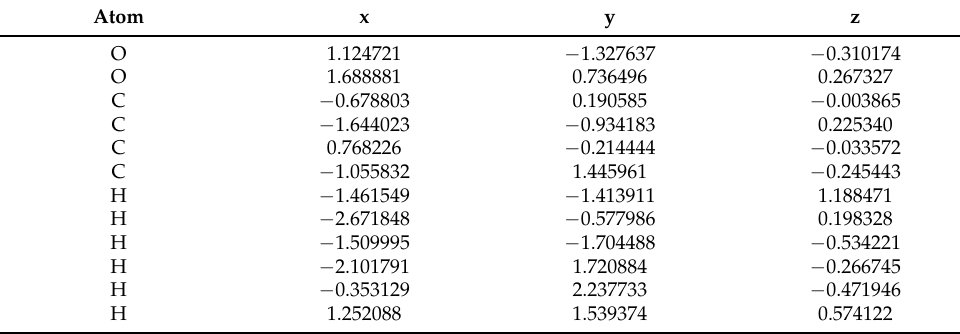
Table A4. Optimized geometry of the trans-ring (TR)